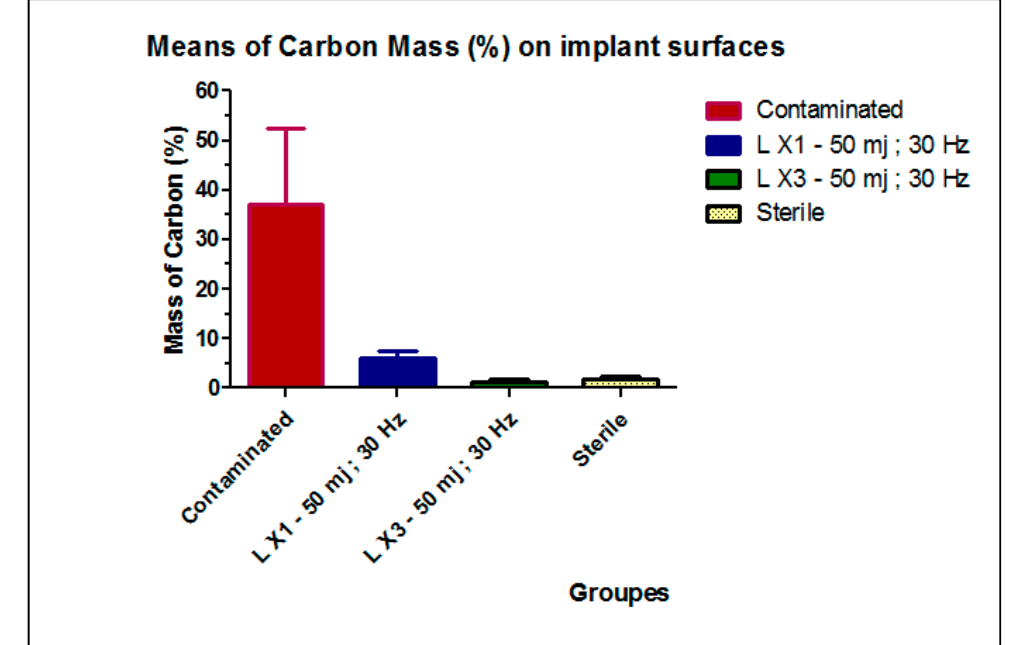
Figure 6. Means of the Carbon mass (%) on the implant surfaces in the sterile, contaminated, LX1, and LX3 groups.